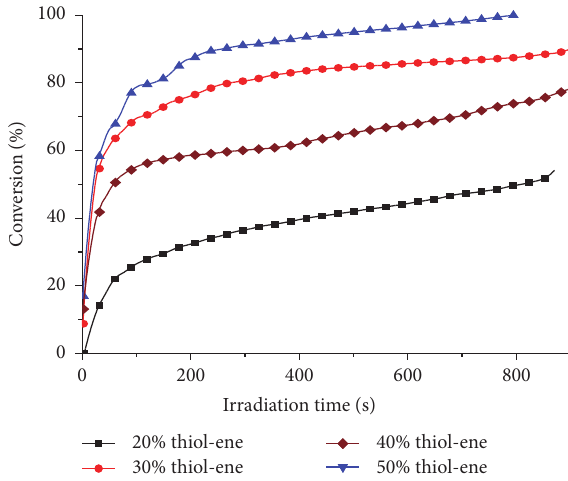
Figure 5: Comparison of the kinetic profiles of the double bonds during the photopolymerization of DGEBA with varying concen- trations of the thiol-ene system. The photopolymerizations were performed at a temperature of 85 ∘ C with UV light intensity of 40 mW/cm 2 . The photoinitiator DMPA and the catalyst TBP were added at